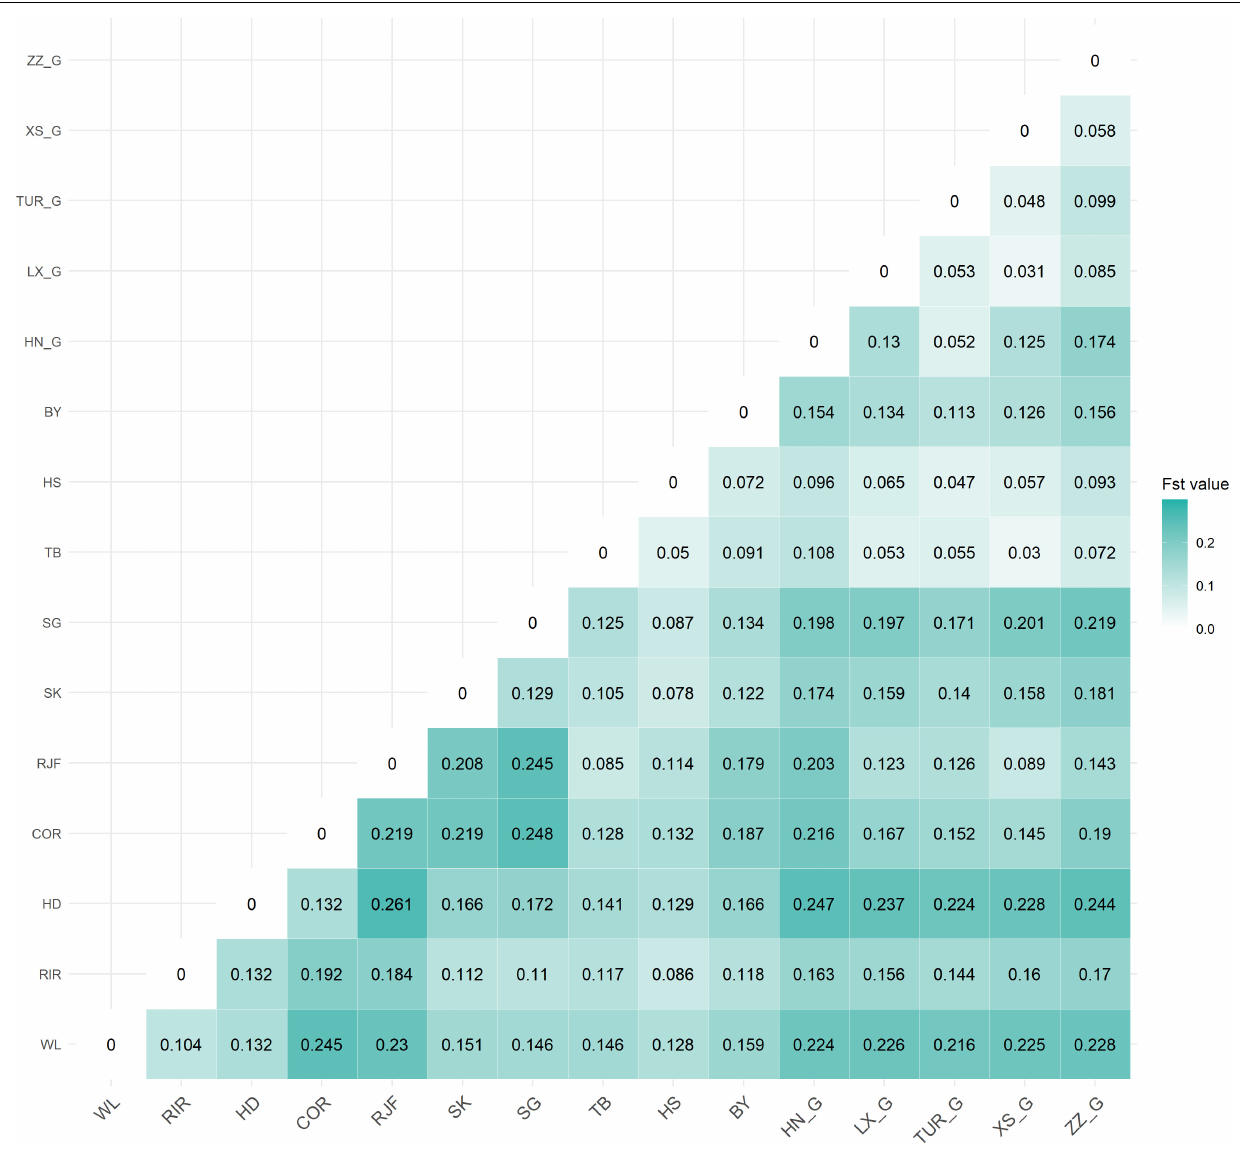
were local breeds and 29 regions did not contain genes, covered 1,598 genes ( Supplementary Table S2